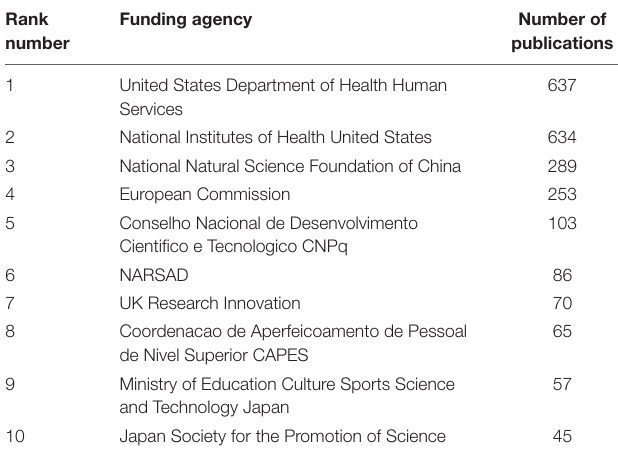
TABLE 4 | Top 10 funding agencies with publication